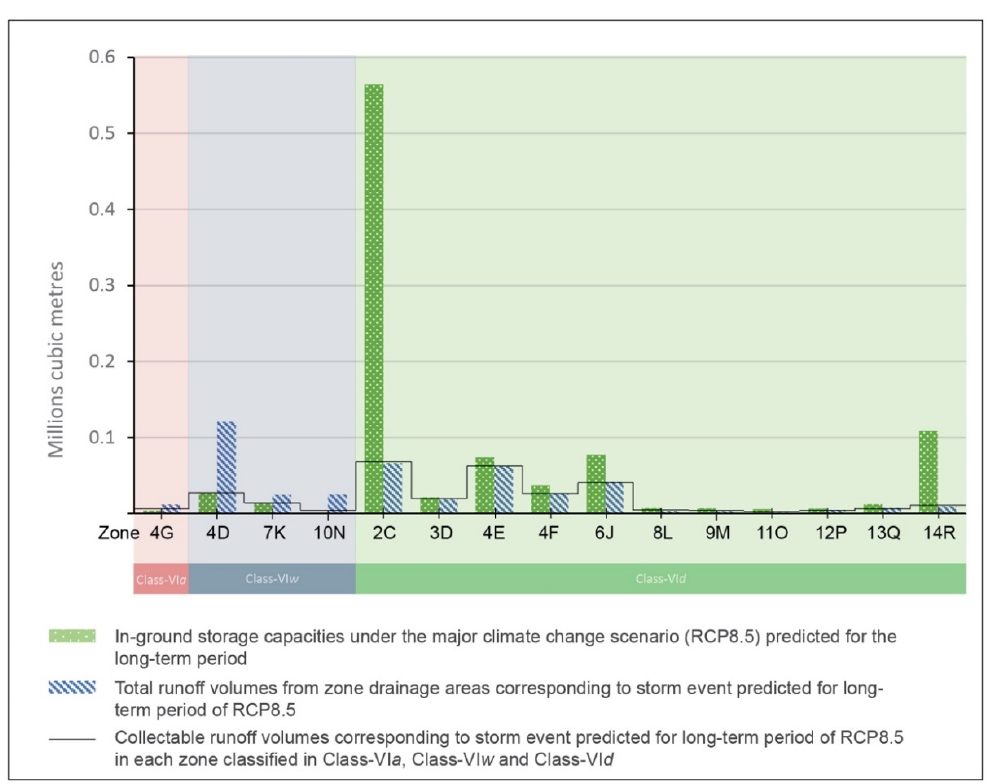
Figure 11. The collectable runoff volumes of SWM zones classified as Class-VI under the long-term major climate change scenario (RCP8.5) are presented by the black line. The zones are grouped according to their key limiting factors. Zones having the potential GSI area ( a -highlighted in pink) and the high groundwater level ( w -highlighted in blue) as key limiting factors have runoff volumes (blue bar) exceeding their storage capacities (green bar). Meanwhile, zones with the size of drainage area ( d -highlighted in green) as the key limiting factor have excess storage capacity, which could be used to increase their FMCs if water could be transferred from other zones with excess runoff.